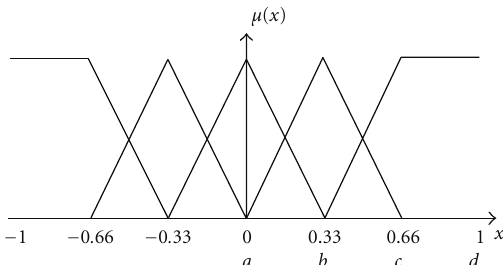
Figure 9: Normalization of the input MFs. The tuning factor is r = 1.